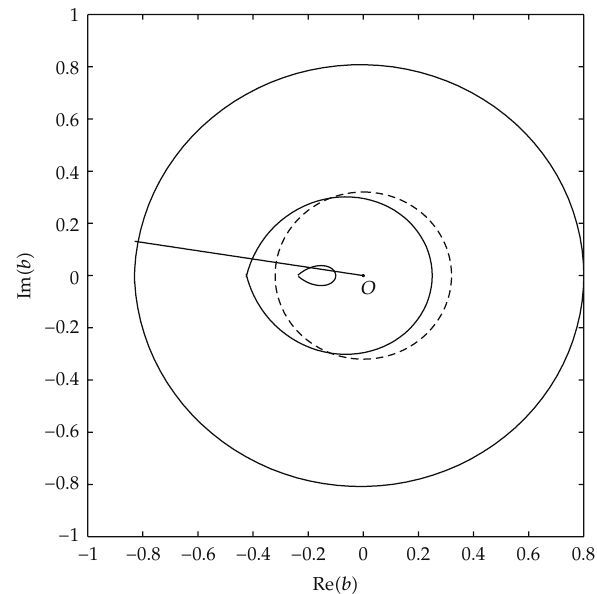
Figure 3: Stability ovals for k (cid:3) 6 , a (cid:3) 0 . 2 , and a (cid:3) 0 . 75; a (cid:3) 1 . 1. A circle b (cid:3) 0 . 33exp (cid:5) iα (cid:8) and a beam b (cid:3) r exp (cid:5) i 19 π/ 20 (cid:8) are constructed for Examples 2.3 and